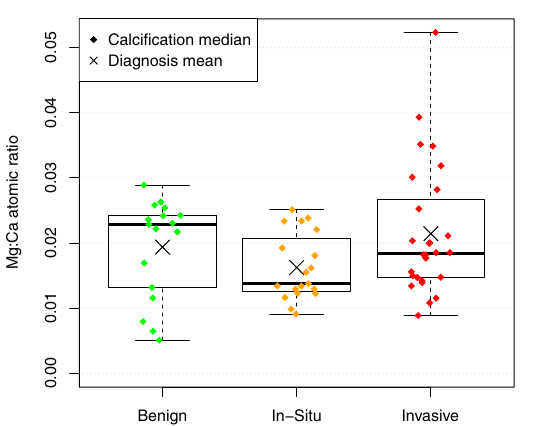
Figure 5. No significant difference in Mg:Ca ratio for calcifications was found between diagnoses.